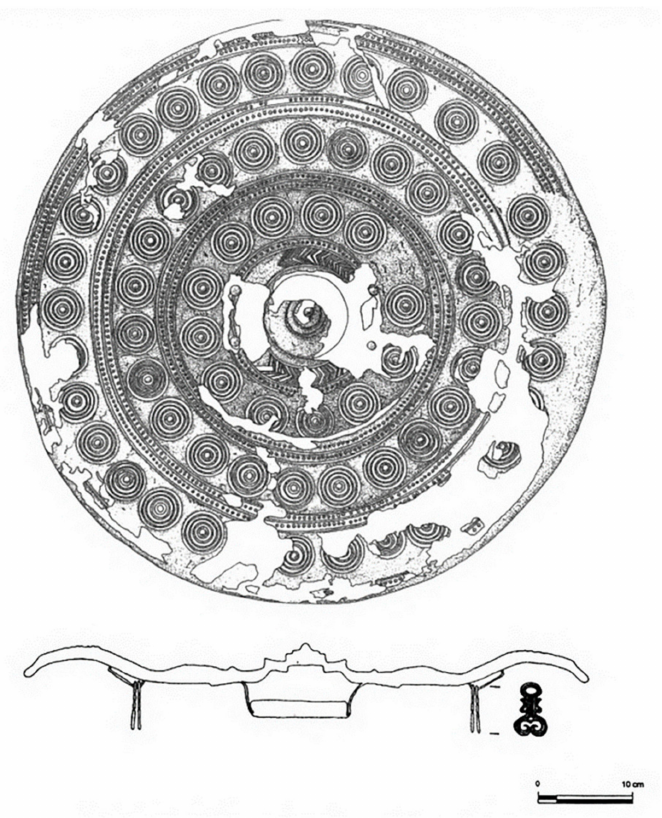
Figure 8. Example of the early reconstruction on VG013, after Drago Troccoli [64] (p.